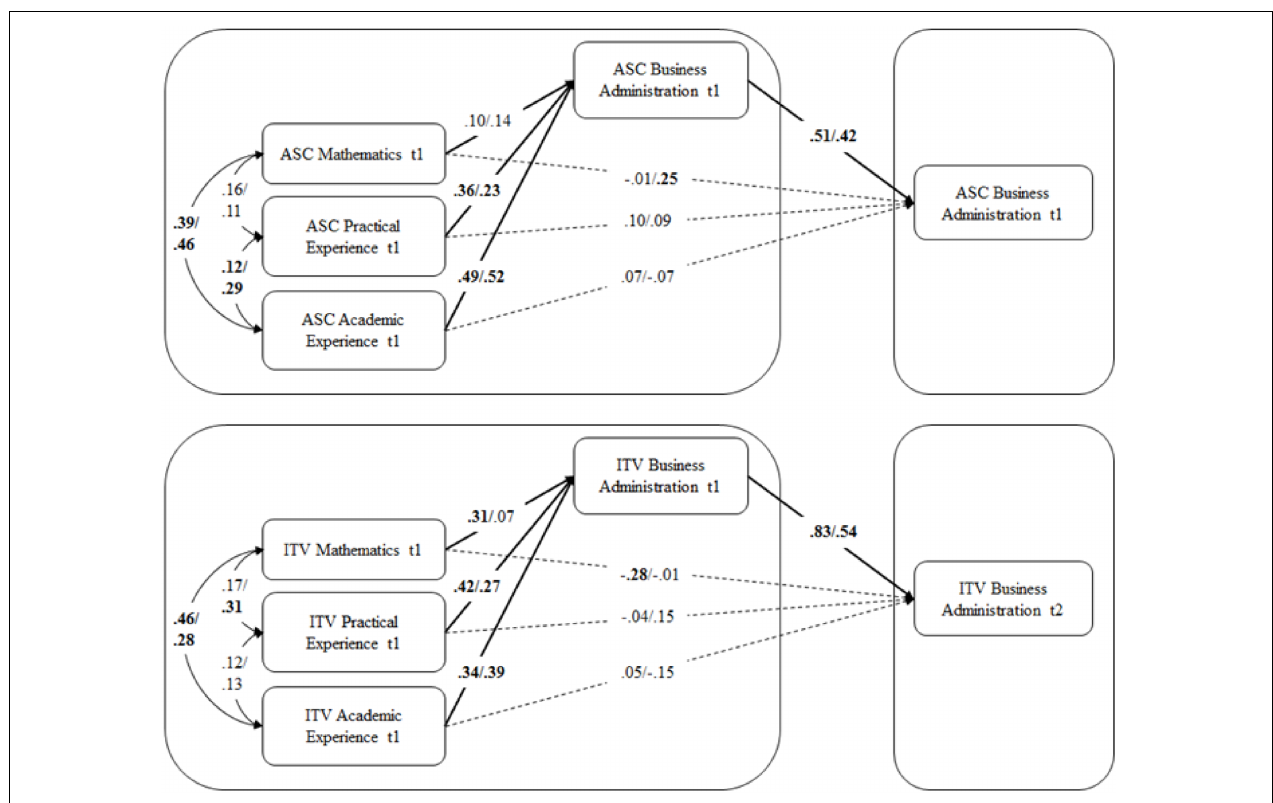
FIGURE 5 | Multiple-group SEM of predictors of first-year students’ academic self-concept and intrinsic task value, respectively, and stability over the first semester for students without/with substantial study-relevant prior experience. ASC, academic self-concept; ITV, intrinsic task value; significant coefficients ( p < 0.05) are printed in bold, for further description see